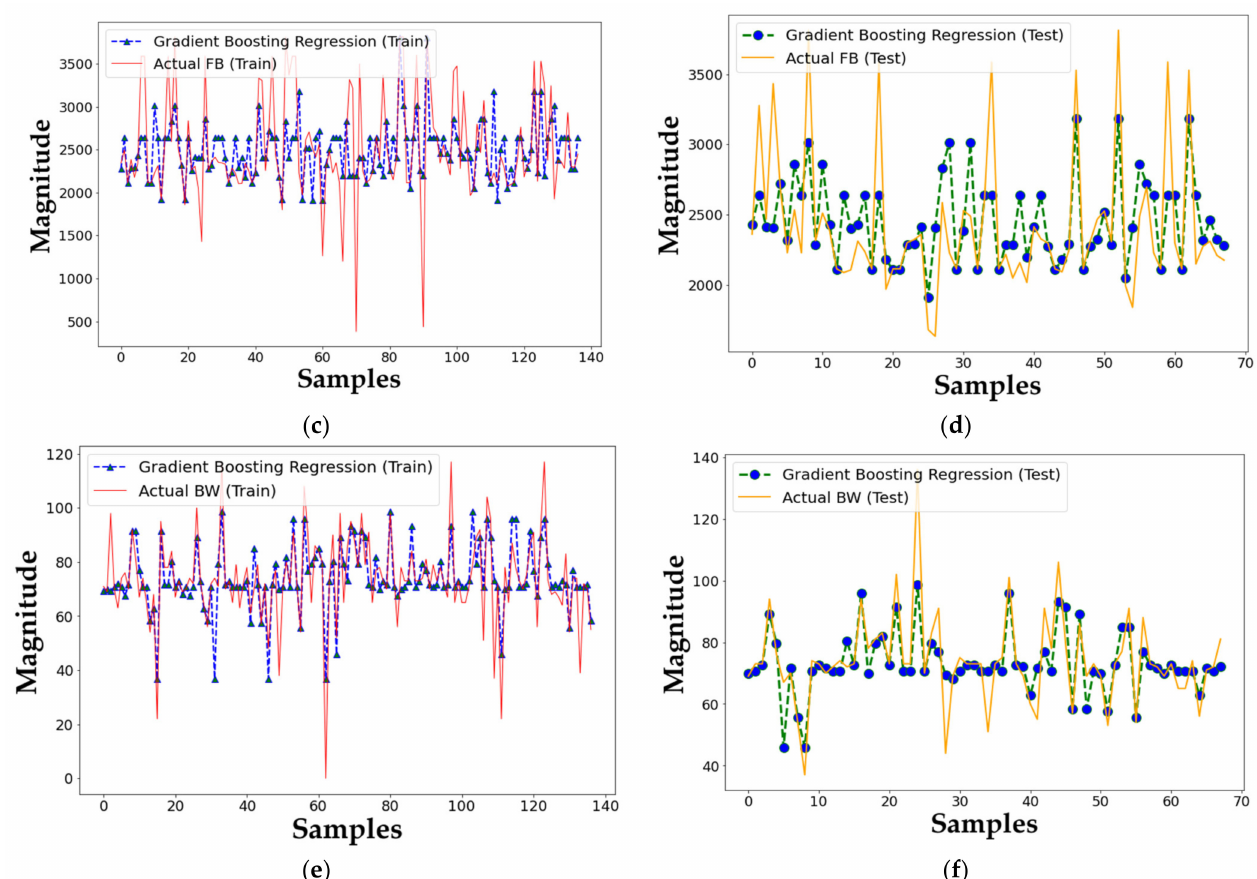
Figure 13. Description of the performance of Gradient Boosting Regression Algorithm in modelling the digital twins of the alloy based on A20 ( a , b ); FB ( c , d ); BW ( e , f ) in the presence of all inputs including heating, QT, PT, and Pt; ( a , c , e ): Train and ( b , d , f ):